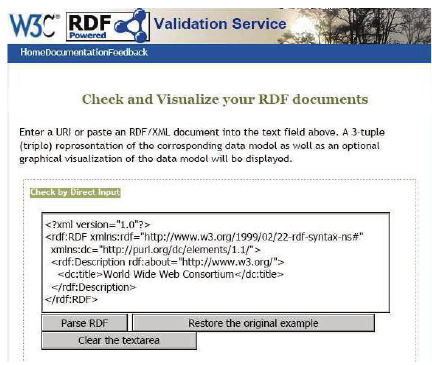
Figure 4: W3C RDF validation